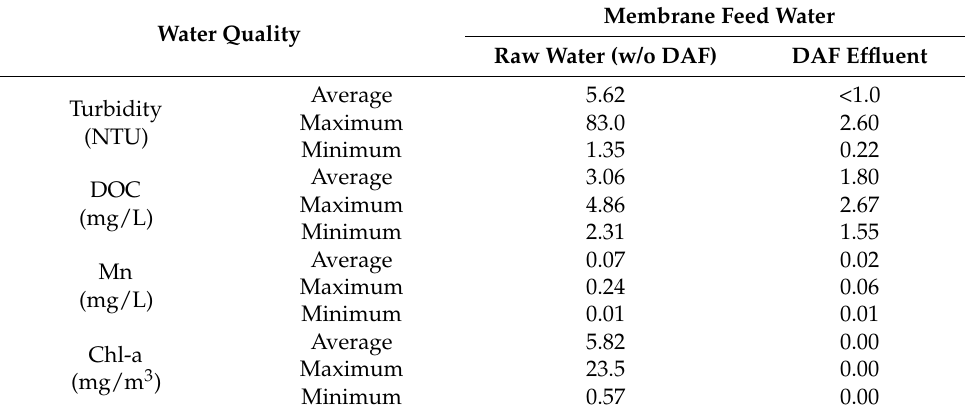
Table 1. Raw water (Hoedong Reservoir, Busan)